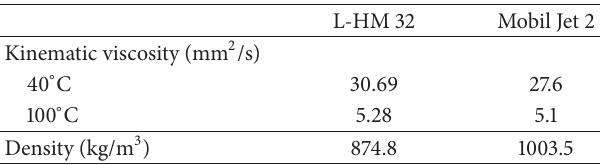
Table 2: Properties comparison of L-HM 32 hydraulic oil and